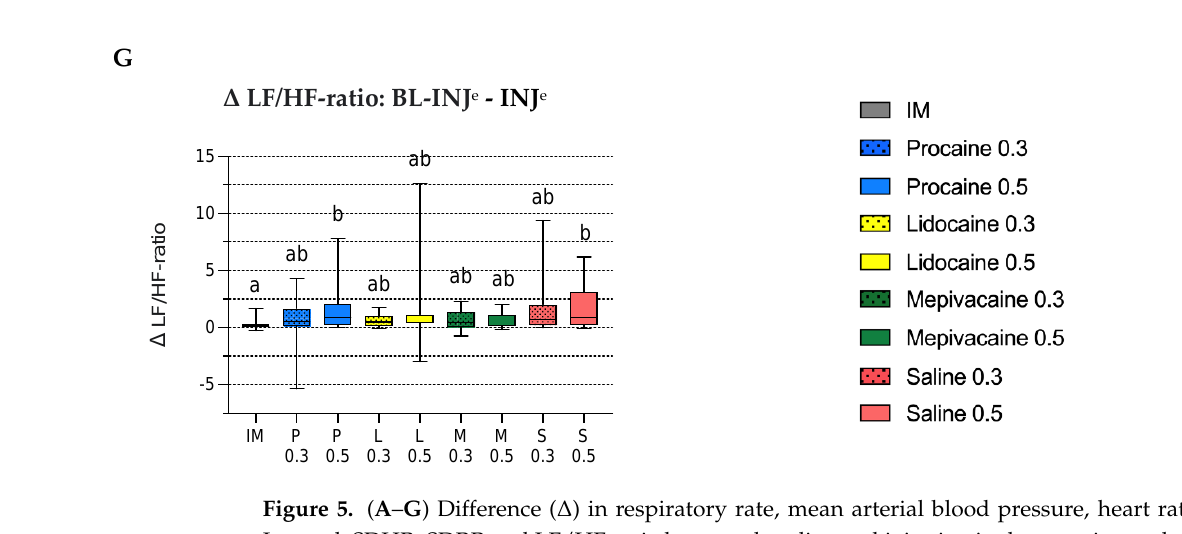
Table 2. Number of piglets showing nocifensive movements during skin incision, exteriorization of testicles and emasculation ( n = 20/group).